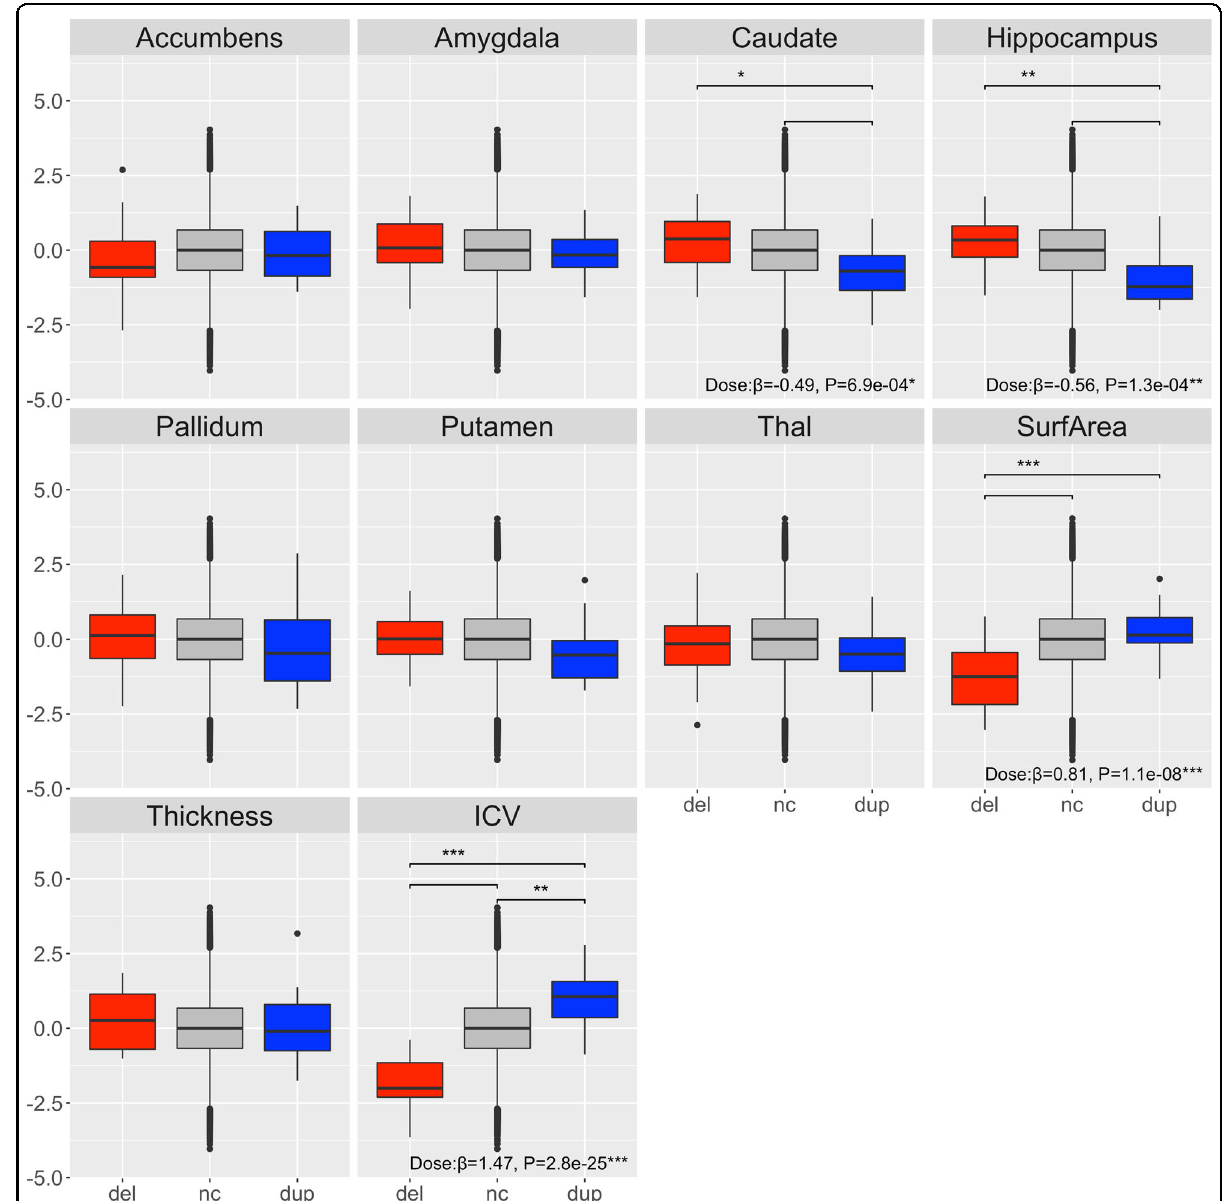
Fig. 1 Cortical surface area and ICV show a positive dosage effect and caudate and hippocampus a negative dosage effect to copy number in the 1q21.1 distal region in our main sample (ENIGMA-CNV and UK Biobank). Boxplots of subcortical volumes, cortical surface area and mean cortical thickness and ICV are shown. Deletion carriers (del) in red, non-carriers (nc) in grey and duplication carriers (dup) in blue, respectively. The normalized brain values are presented. Boxplots represent the mean. Copy number dosage effect is noted at the bottom of each panel. Signi fi cant differences after correction between groups are noted as * P < 0.0014, ** P < 0.00014, *** P = 0.000014. Centre line represents the median, box limits are the upper and lower 25% quartiles, whiskers the 1.5 interquartile range and the points are the outliers. All analyses were corrected for age, age squared, sex, scanner site and ICV (except for